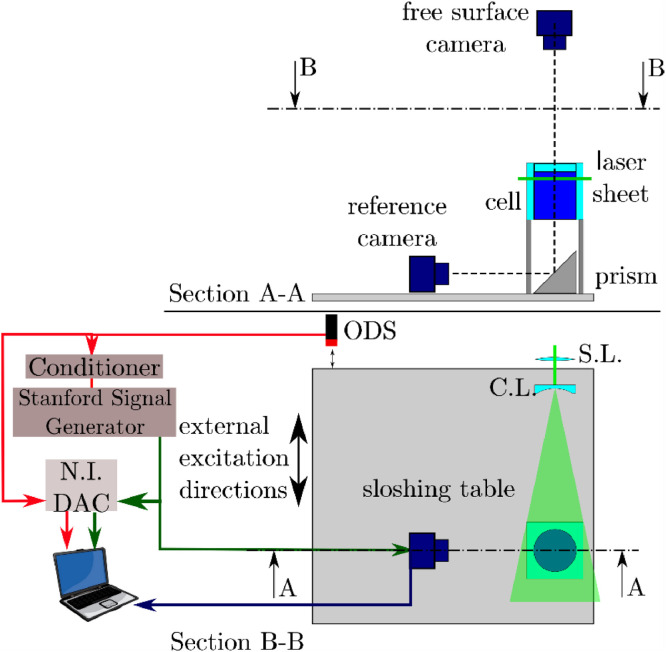
Sketch of the experimental apparatus [3].